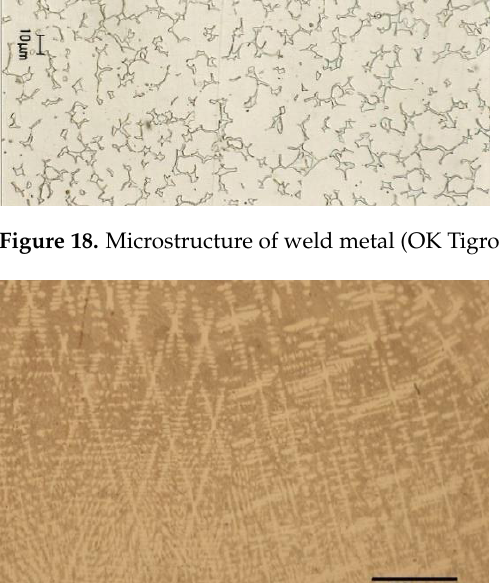
Figure 19. Microstructure of cladding layer (Lincore 60-O).